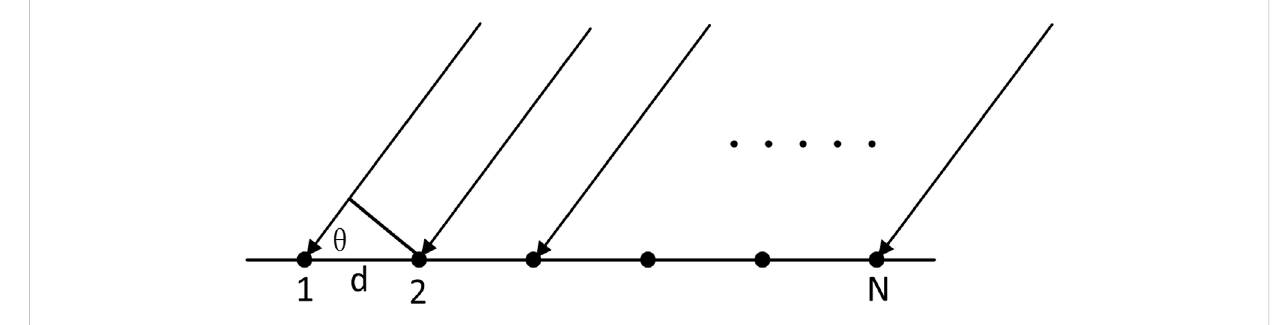
FIGURE 4 Diagram of an array